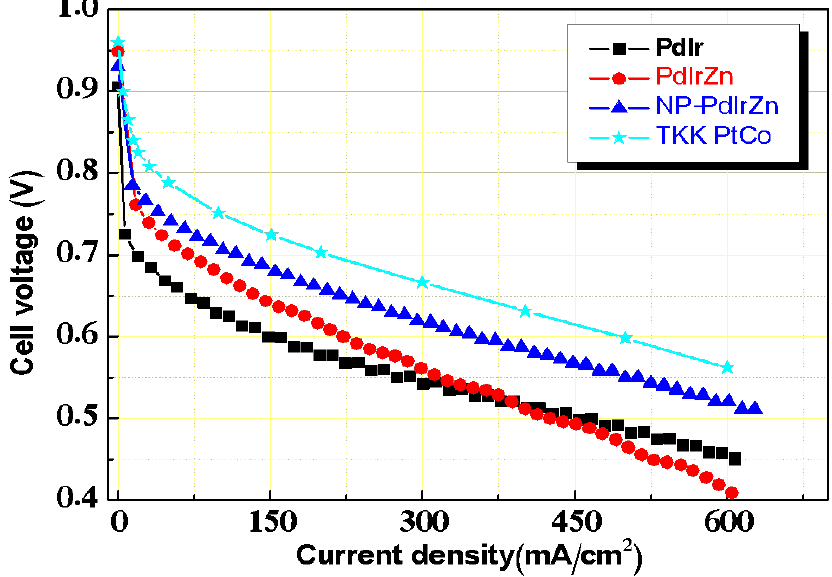
Figure 5. Mass ORR activity of PdIr, PdIrZn, NP-PdIrZn, and TKK PtCo catalysts by linear sweep voltammetry.